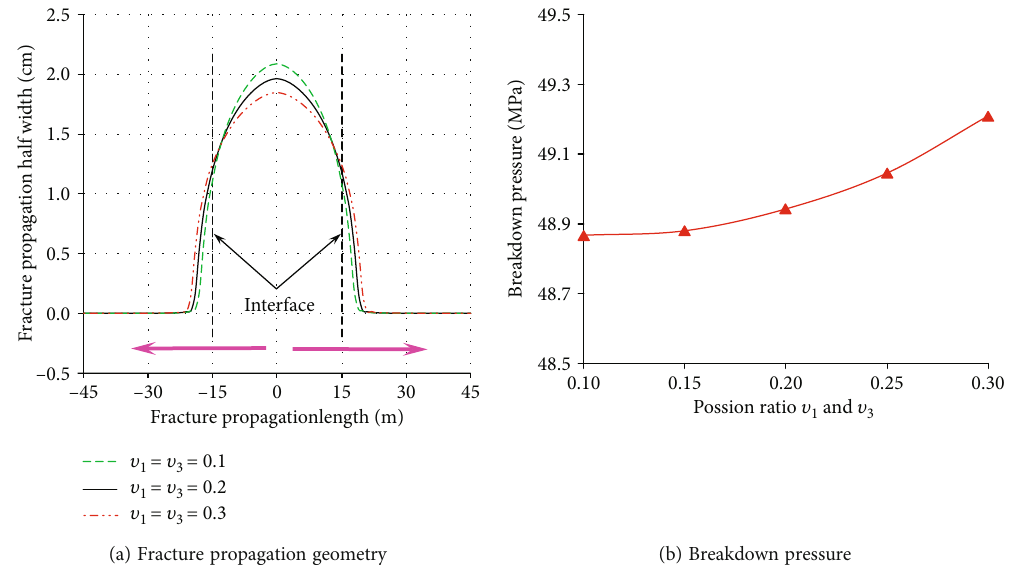
Figure 11: E ff ect of Poisson ’ s ratio contrast on the fracture propagation geometry and breakdown